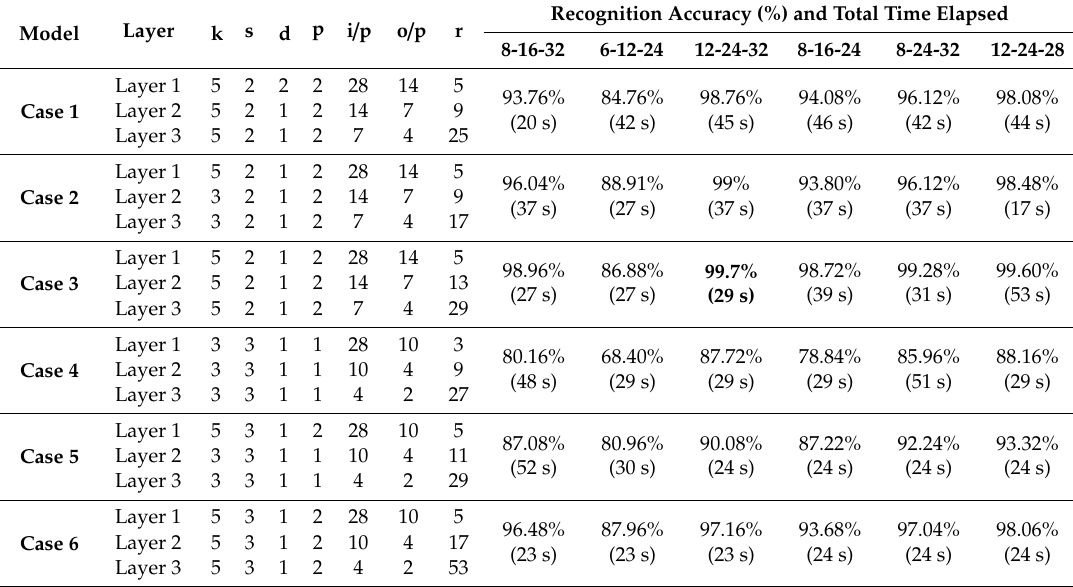
Table 2. Configuration details and accuracy achieved for convolutional neural network with three